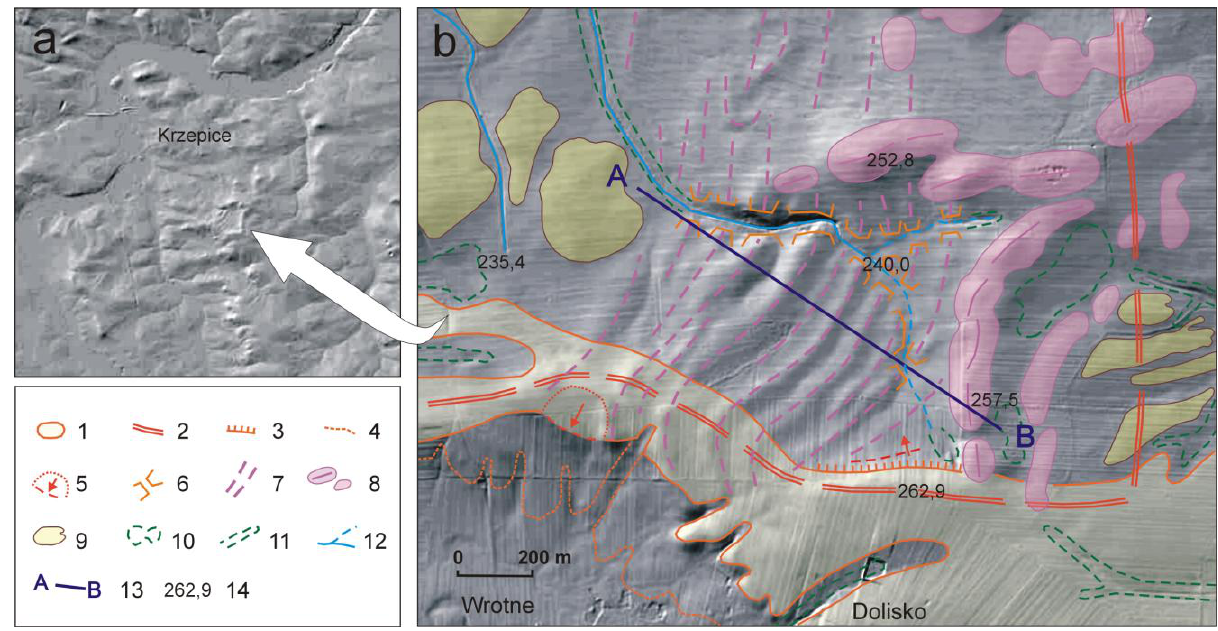
Fig. 2. Landforms in the vicinity of